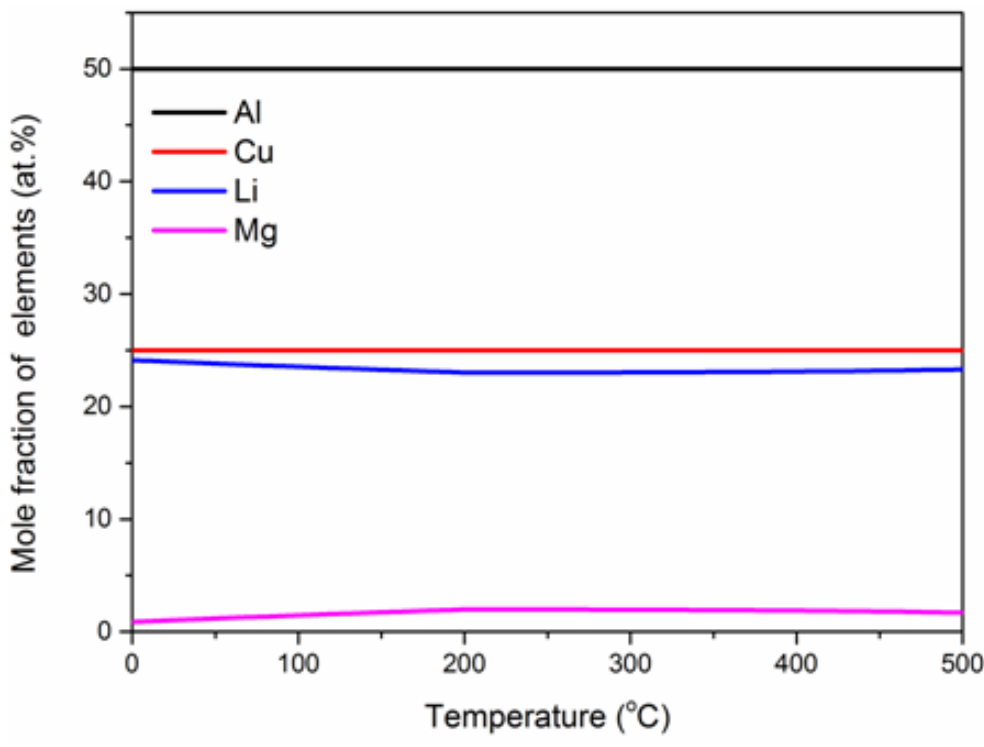
Figure 11. The content of elements in T1-Al2CuLi phase.